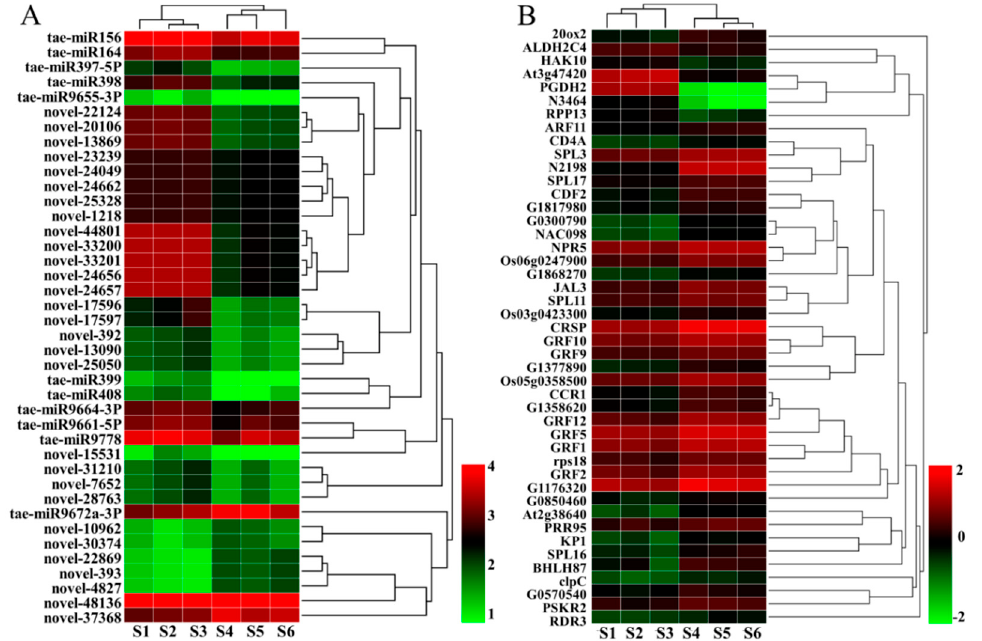
Figure 9. Heat maps of the differentially expressed miRNAs and mRNA between dmc and WT. ( A ) Heat map of the DEMs. ( B ) Heat map of the DEGs. S1, S2, S3: mutant dmc ; S4, S5, S6: WT. The color scales indicate the values of LgFPKM.